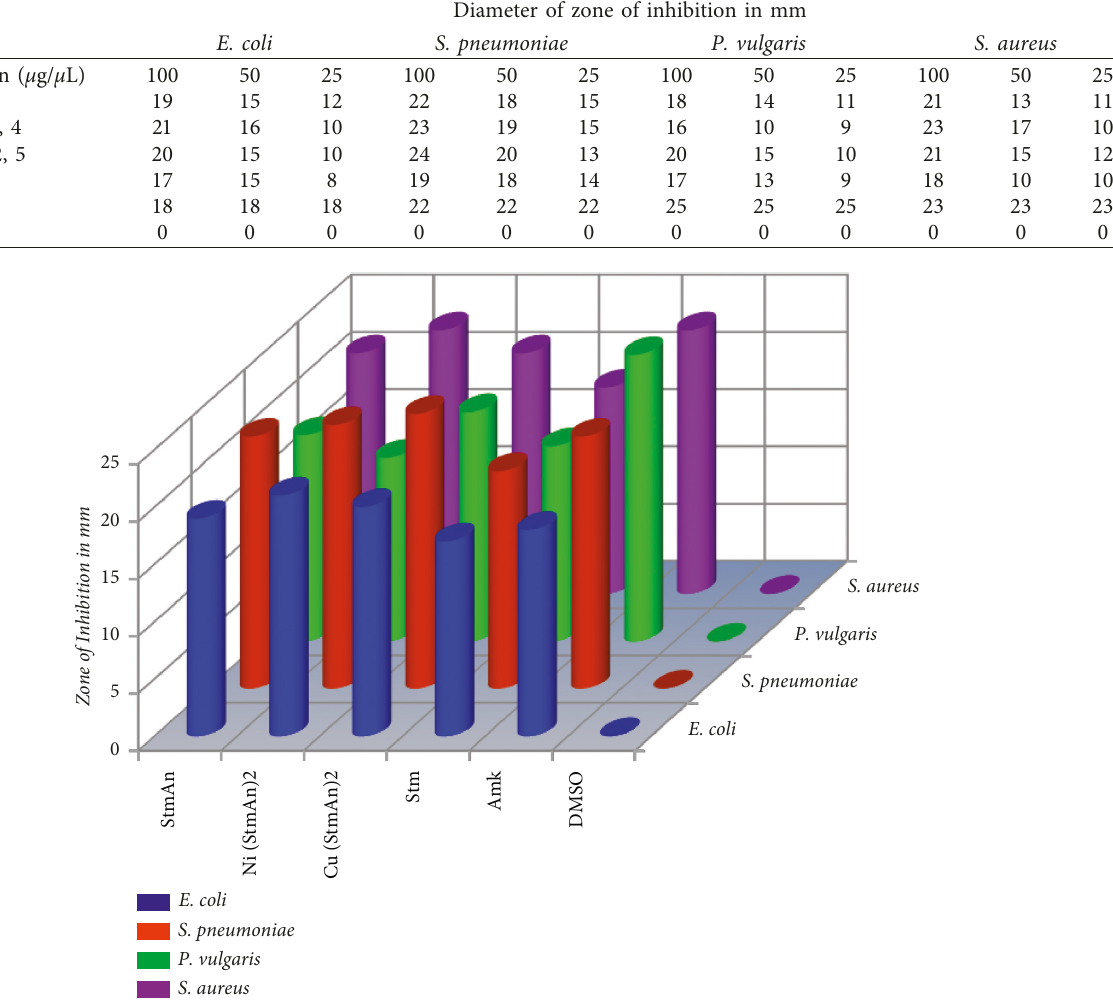
Figure 6: Bar graph showing the antibacterial activity at 100 μ g/ μ L concentration. Table 5: Minimum Inhibitory Concentration (MIC) data.